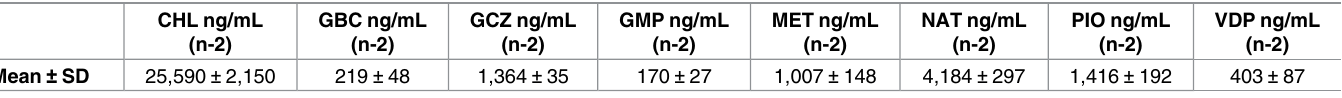
S1 Fig. Calibration curve of analytes in plasma sample during method application.